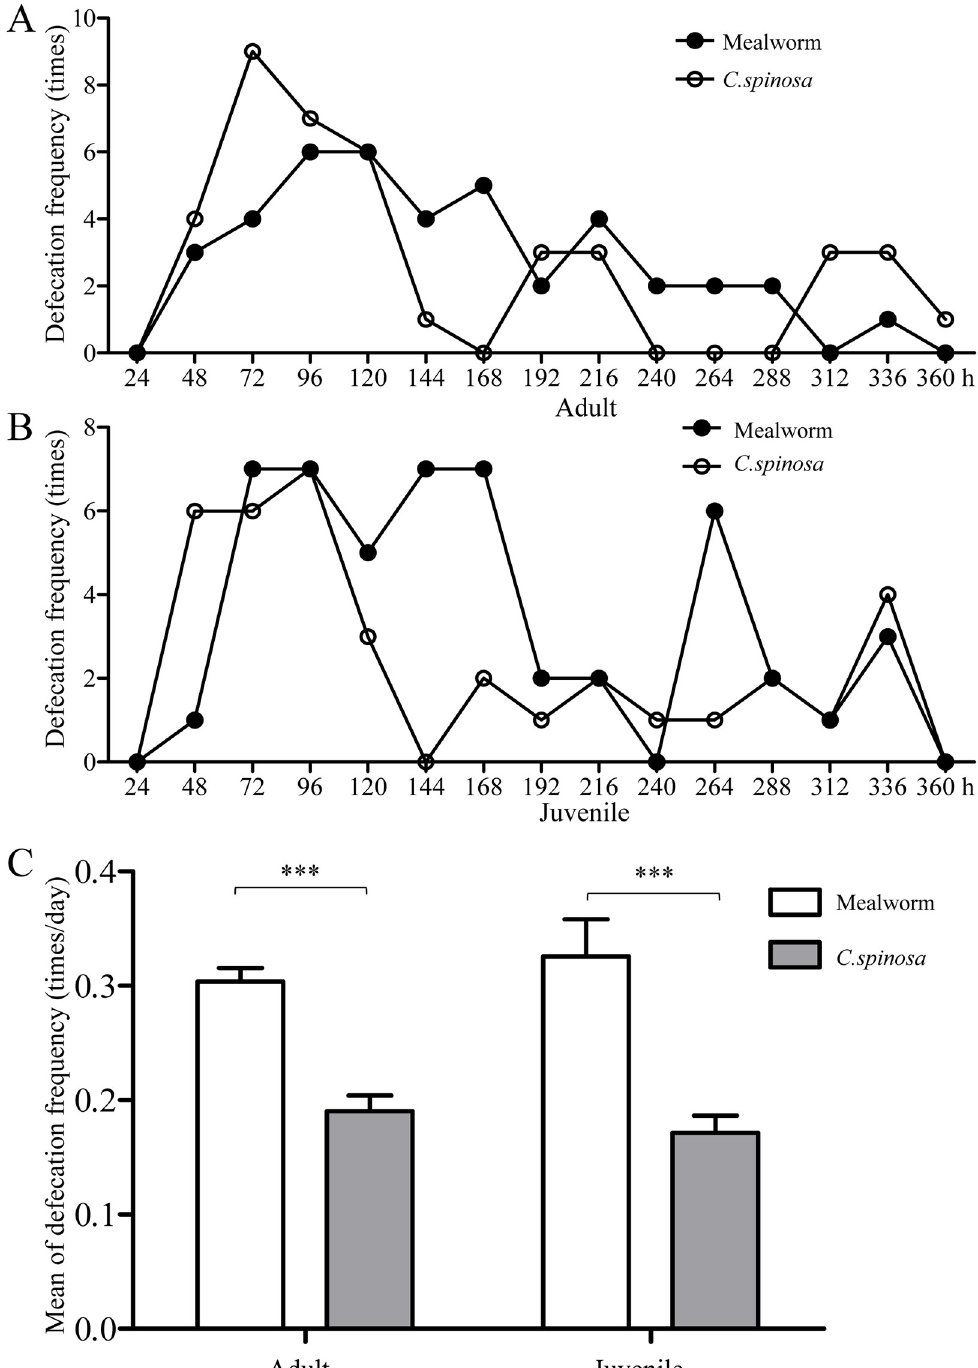
Fig 4. Effects of age and food type on defecation frequencies in adult and juvenile lizards. (A, B) The defecation frequencies of mealworms and C . spinosa in adult and juvenile lizards. (C) The defecation rates of mealworms and C . spinosa in adult and juvenile lizards. The data were analyzed by a two-tailed paired t test. ��� P < 0.001.